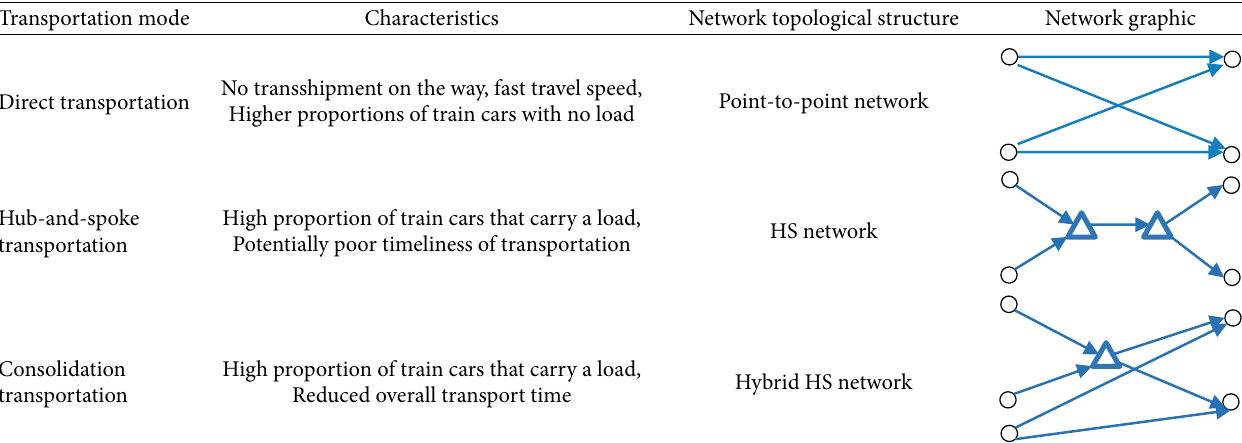
Table 2: Transportation modes and network topological